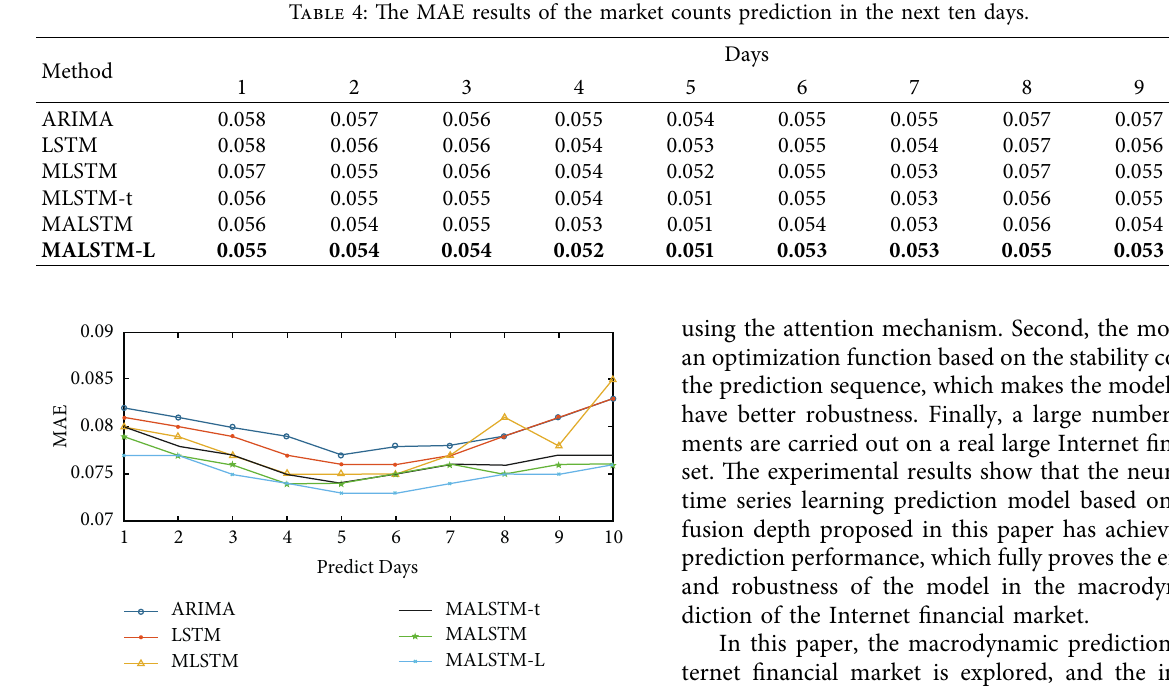
Figure 6: Experimental results of RMSE.